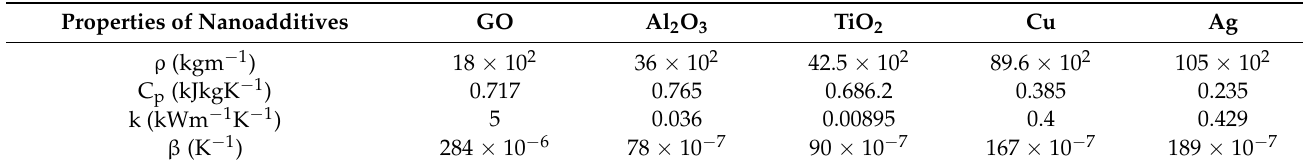
Table 2. The thermophysical properties of five nanoparticles [26–28]. Properties of